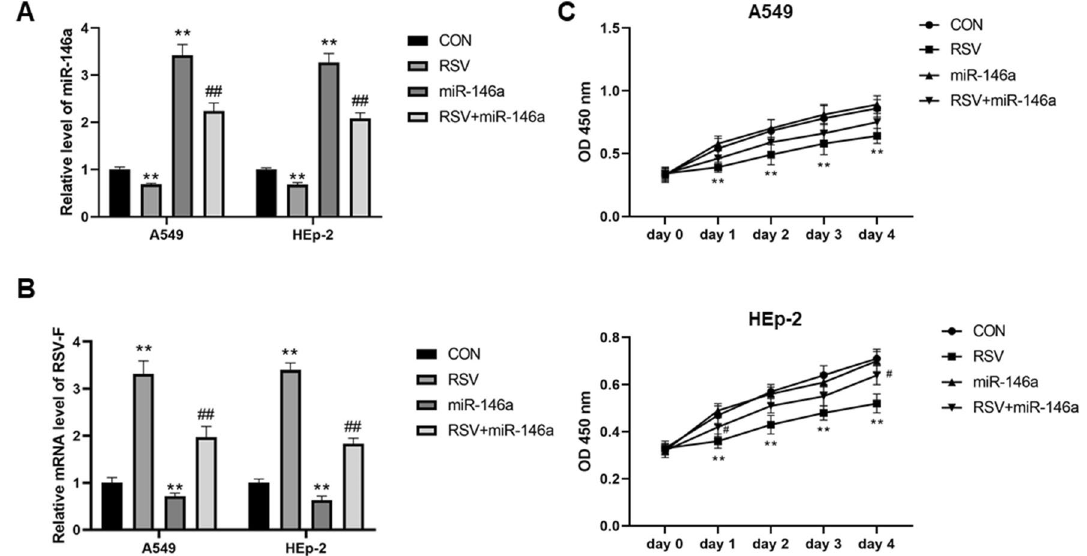
Figure 1. Overexpression of miR-146a slow down the accelerated cell growth induced by RSV infection. ( A ) RSV infection increased the expression of RSV-F in both A549 and HEp-2 cells, and overexpression of miR- 146a significantly reduced the expression level of RSV-F mRNA; ( B ) After RSV infection, miR-146a levels were significantly decreased in both A549 and HEp-2 cells, and miR-146a mimics effectively increased the expression levels of miR-146a in the two cells; ( C ) Effects of miR-146a overexpression and RSV infection on A549 and HEp-2 cell proliferation; ** P < 0.01, compared with the CON group; ## P < 0.01, compared with the RSV